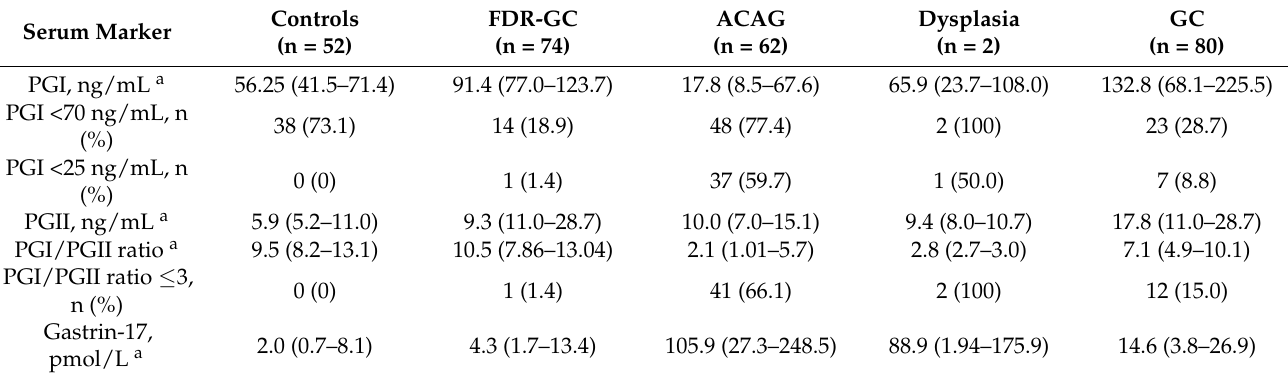
Table 4. Serum markers, by study group.